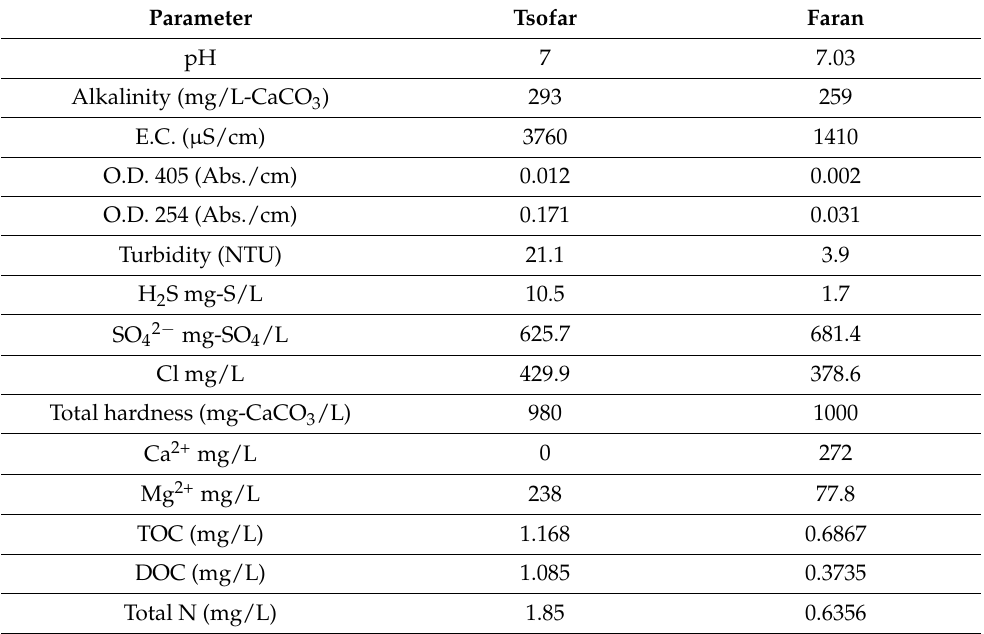
Table 1. Chemical and physical characterization of two natural groundwater sources from the Arava Valley